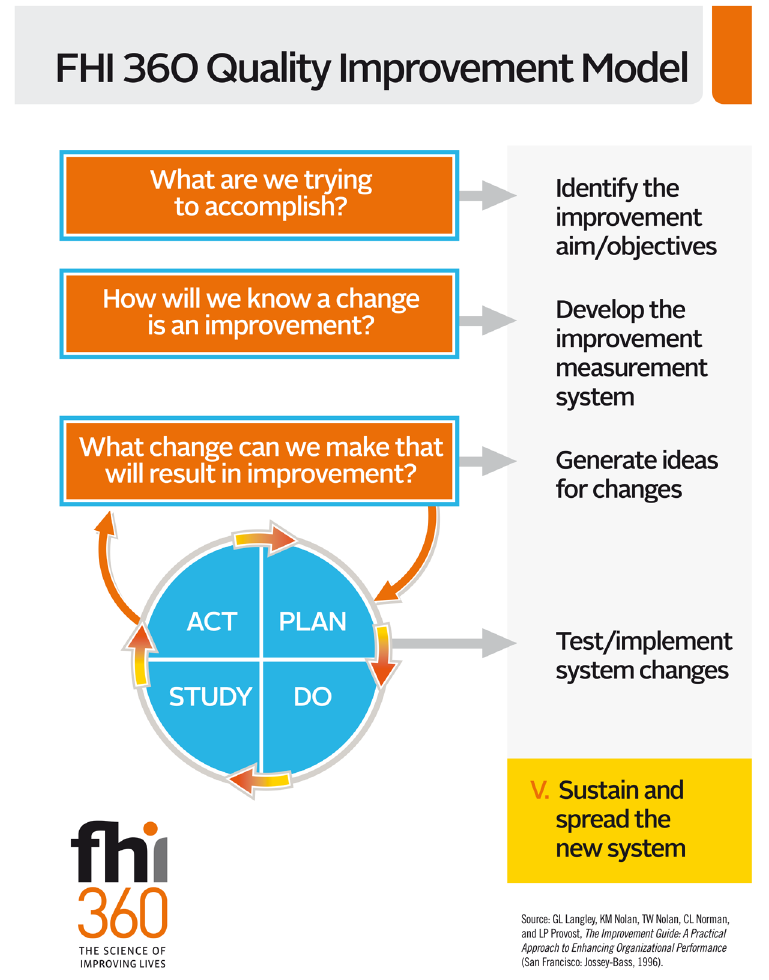
Model.Figure 1. FHI 360 Quality Improvement